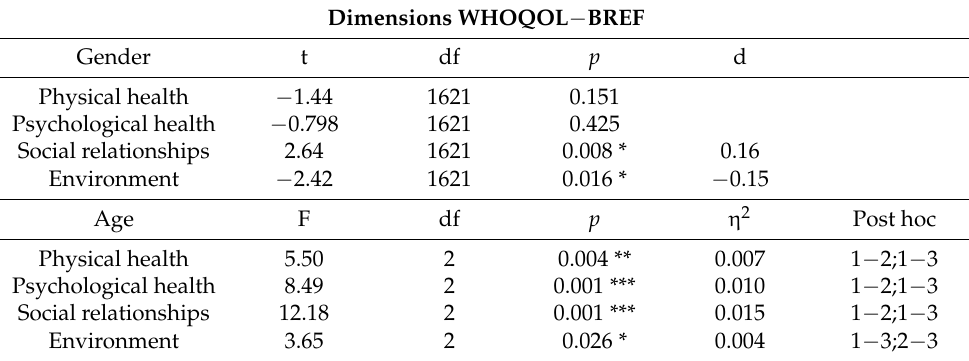
Table 2. Student’s t -test results according to gender and